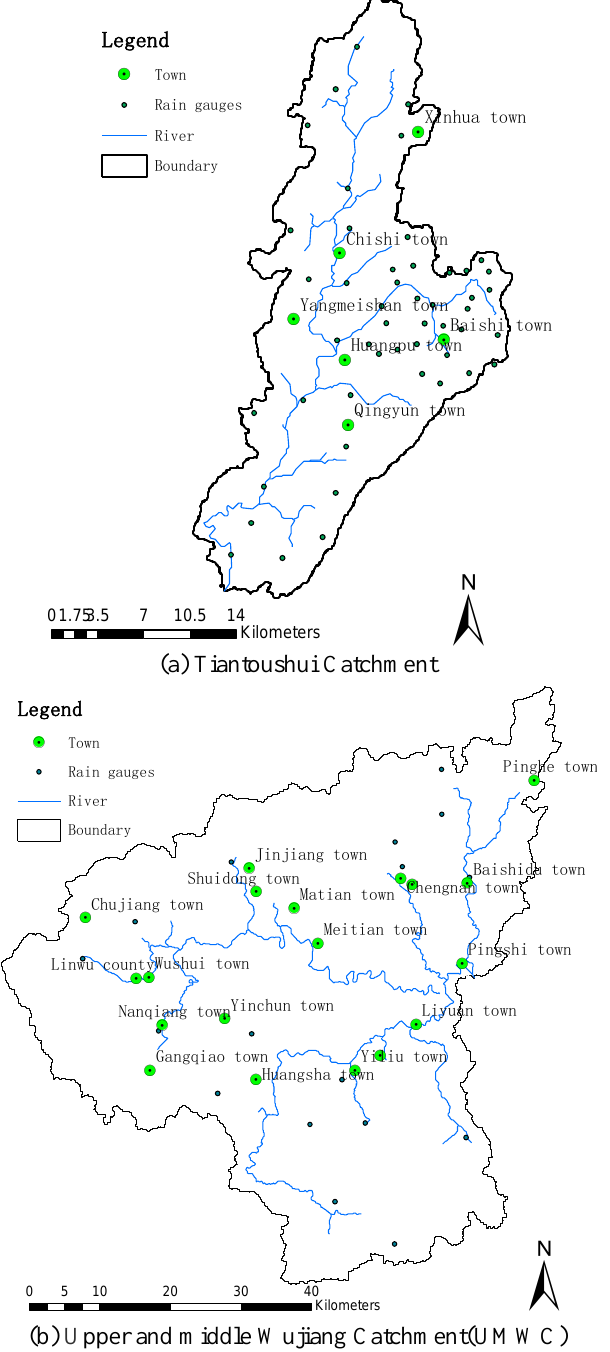
(b) Upper and middle Wujiang Catchment(UMWC) Figure 1 sketch map of the studied Catchments Figure 1. Sketch map of the studied catchments: (a) Tiantoushui catchment and (b) upper and middle Wujiang catchment (UMWC).